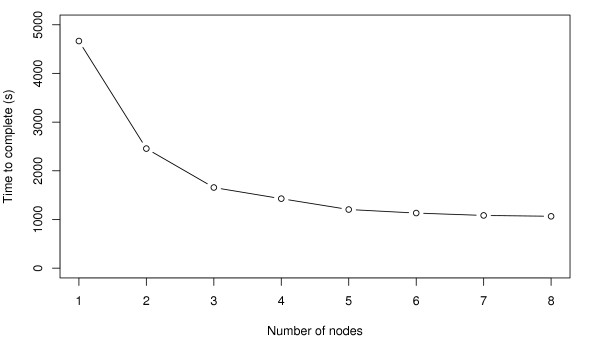
Parallelisation speed-up. Execution times for a typical run of the pumaComb function using different numbers of nodes.